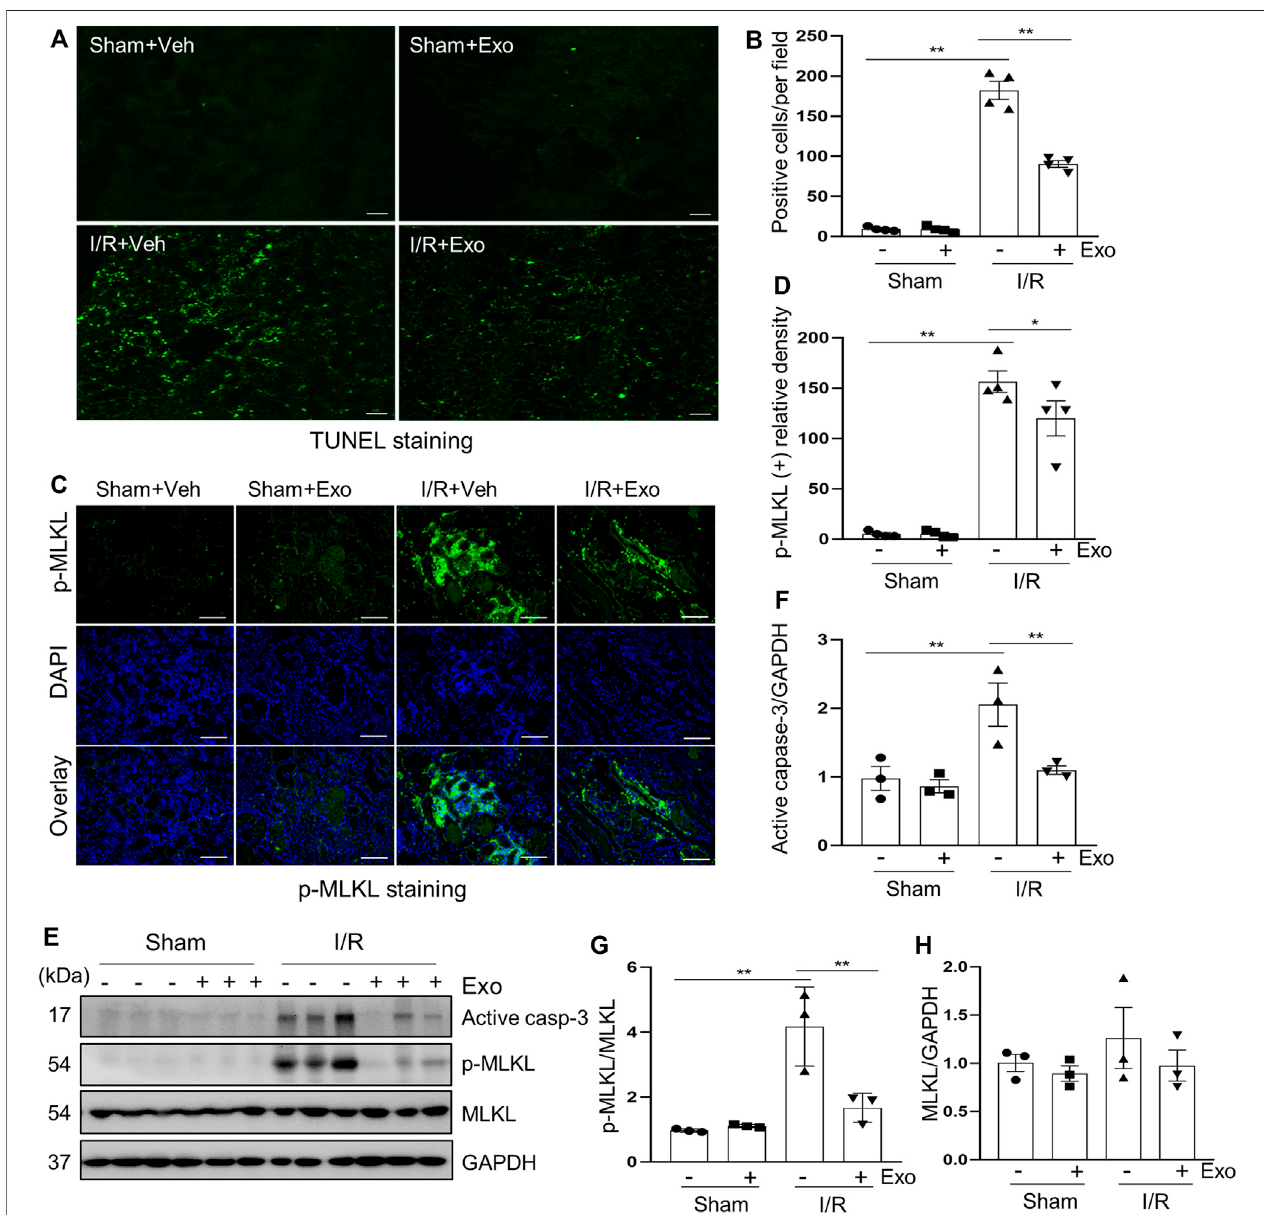
FIGURE 5 | Exosomes down-regulated apoptosis and necroptosis levels in pigs with acute kidney injury induced by ischemia-reperfusion. (A) Representative images of TUNEL staining of kidney tissue from four groups. Scale bar = 100 µm. (B) Quanti fi cation and plot of the TUNEL stained images. (C) Photomicrographs illustrating immuno fl uorescence staining of phospho-MLKL. Scale bar = 200 µm. (D) Quanti fi cation and plot of the Immuno fl uorescence integrated density of phospho- MLKL. (E) Porcine kidney tissue lysates from four groups were subject to immunoblot analysis with speci fi c antibodies against cleaved-caspase 3, MLKL, phospho-MLKL. Expression levels of cleaved-caspase 3 (F) and MLKL (H) were quanti fi ed by densitometry analysis and then normalized with GAPDH. The phosphorylation level of MLKL (G) was calculated quantitatively by densitometry. Data are means ± sem.* p < 0.05; ** p < 0.01 versus sham controls.